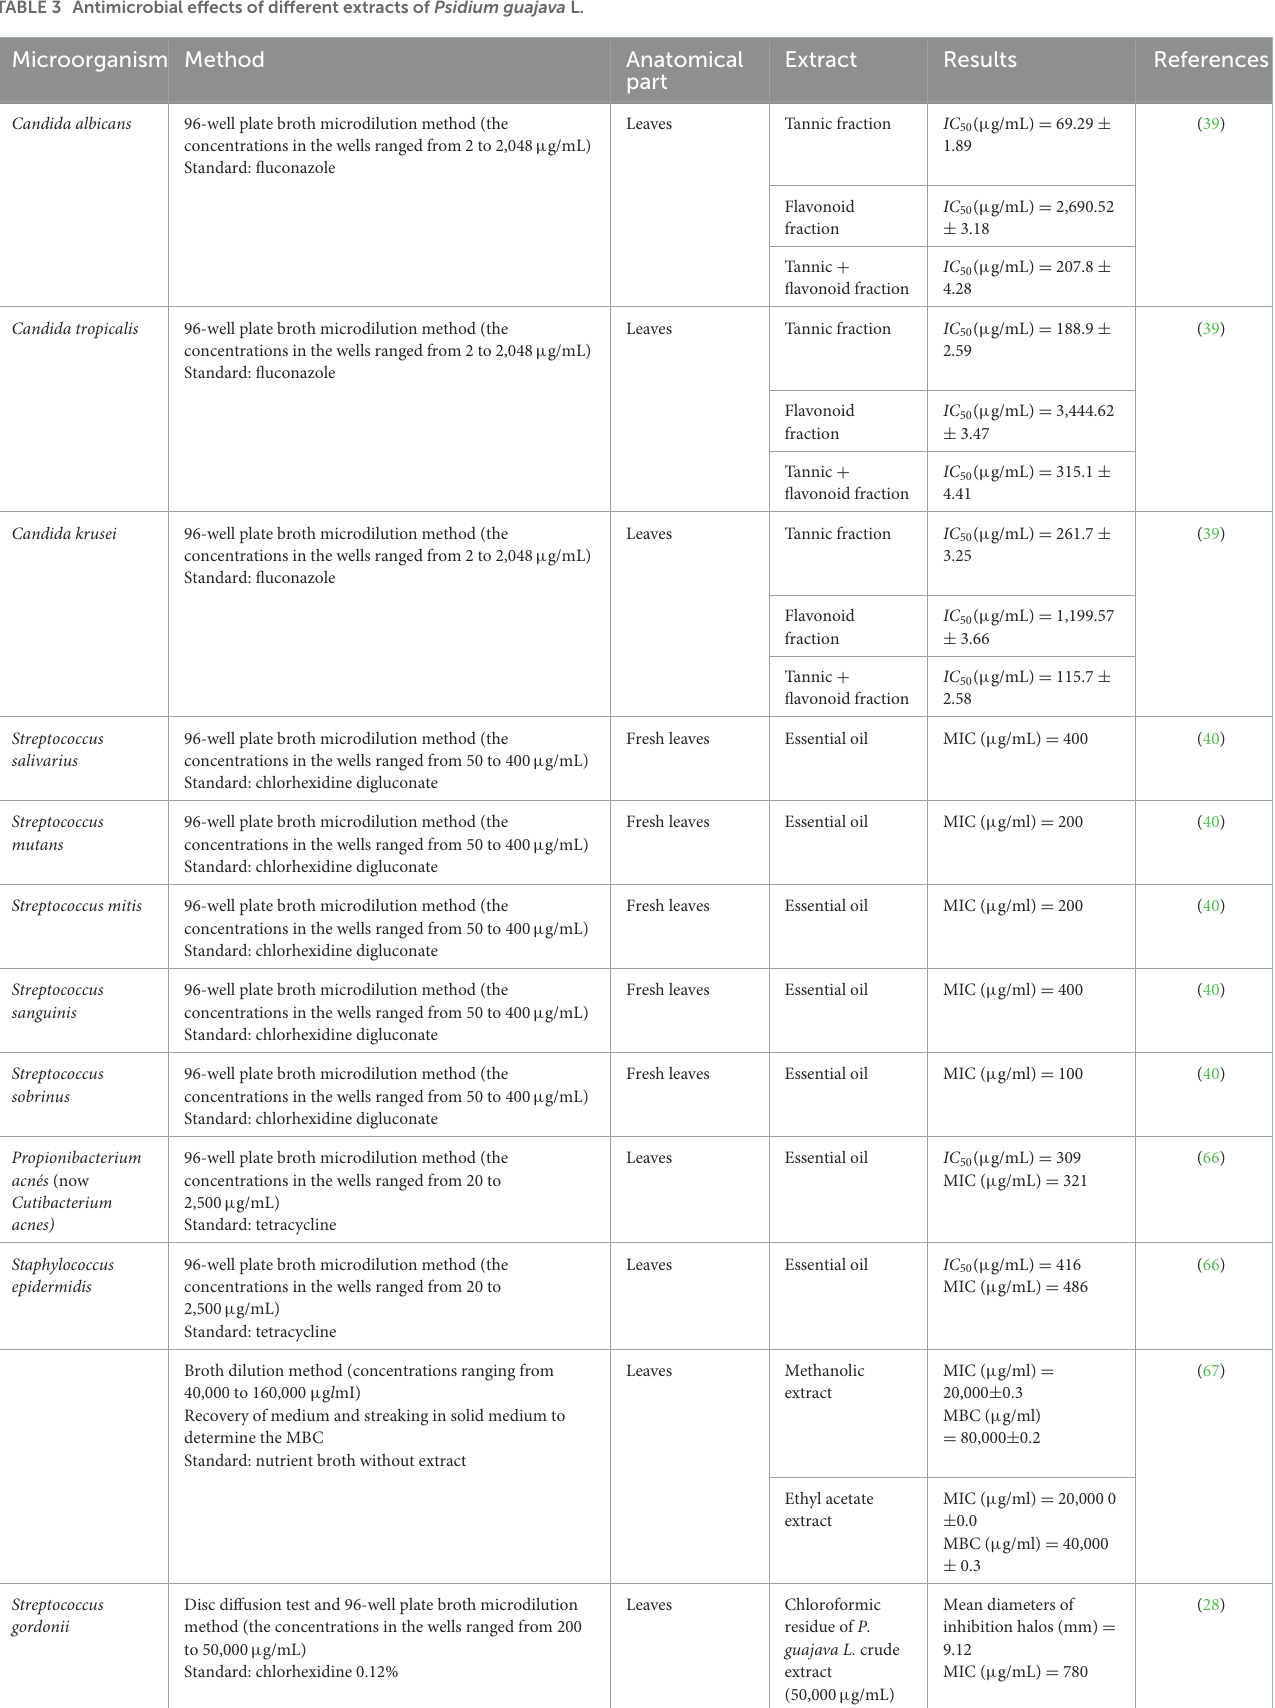
TABLE 3 Antimicrobial effects of different extracts of Psidium guajava